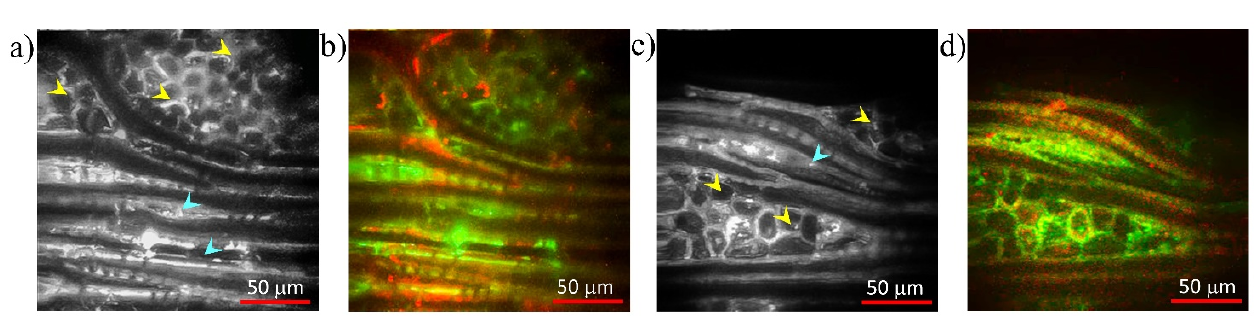
7 of 11 Figure 3. ( a ) Poplar greyscale NLO microscopy images (200 × 200 μ m 2 ) and ( b ) corresponding TPEF/SHG merged images acquired at different depths inside the wood slice (tangential section), highlighting the presence of SHG emitters. Depths of recording from the sample’s surface are indi- cated in the top right corner (81 μ m scanning depth; 1 μ m sampling step). A slightly more intense SHG signal was detected when imaging deeper into the sam- ple, as shown in the combined TPEF/SHG stacks (Figure 3b), which are reported in com- parison to the corresponding greyscale images (Figure 3a). In this case, the SHG signal is confined to small spots and is probably located in the secondary cell walls of vessels. Weaker signals are distributed in the upper part of the analyzed area. 3.2. Beech (Fagus sylvatica L.) Vessels in beech can be found isolated or in the form of aggregates of 2–6 units. They are generally numerous and uniformly distributed inside the growth rings, with size rang- ing between 50 and 75 μ m. Big and abundant pits between vessels are usually organized in horizontal lines. The parenchyma rays, which are generally composed of several series of cells (up to 25), are clearly visible in three of the analyzed areas, as shown in Figure 4a– c (FOV: 100 × 100 μ m 2 ) (FOV: 200 × 200 μ m 2 ). The TPEF/SHG axial stacks of the same area acquired with 5 μ m steps are reported in Figure 4. Contrary to poplar, the SHG signal